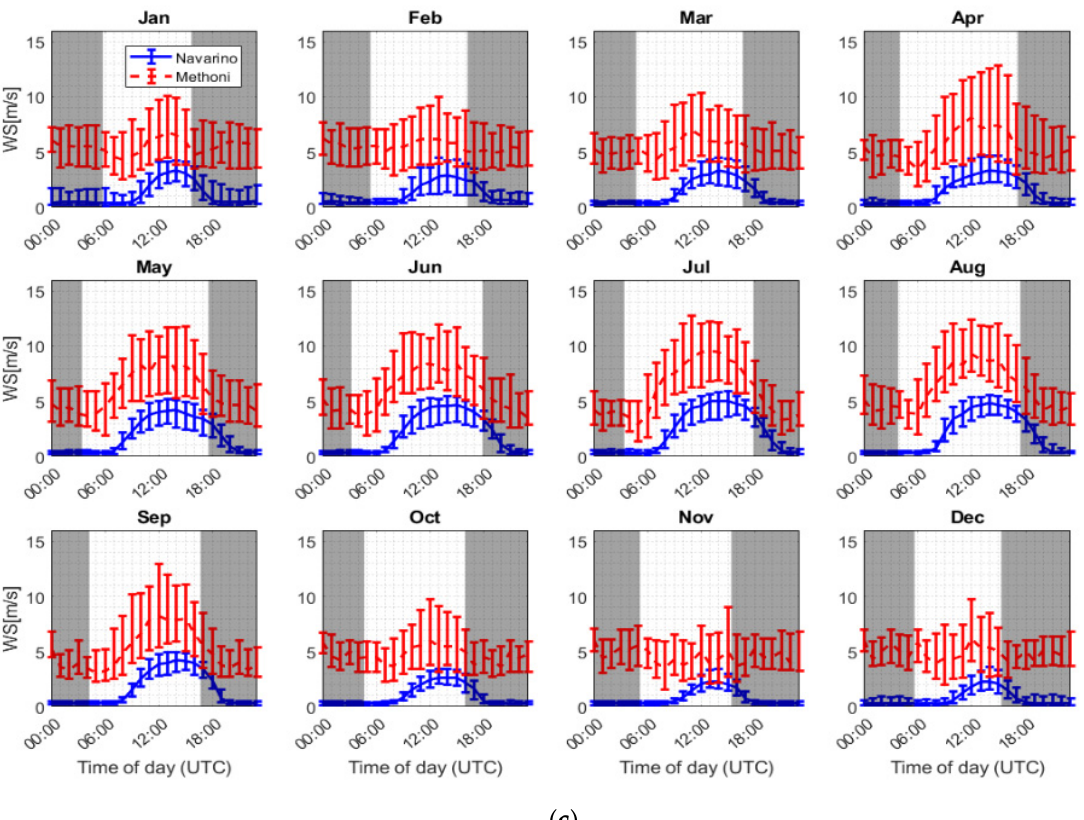
Atmosphere 2021 , 12 , x FOR PEER REVIEW 13 of 28 Figure 5. ( a ) The monthly frequency of local wind directions per hour at Methoni, November 2013 to December 2016. ( b ) The monthly frequency of local wind directions per hour at Navarino, April 2011 to October 2013. ( c ) Monthly median hourly local wind speed for Navarino, April 2011 to October 2013 and Methoni, November 2013 to December 2016, with the 15 to 85 percentile range indicated by the vertical bars. The grey parts show the period when sun is below horizon.